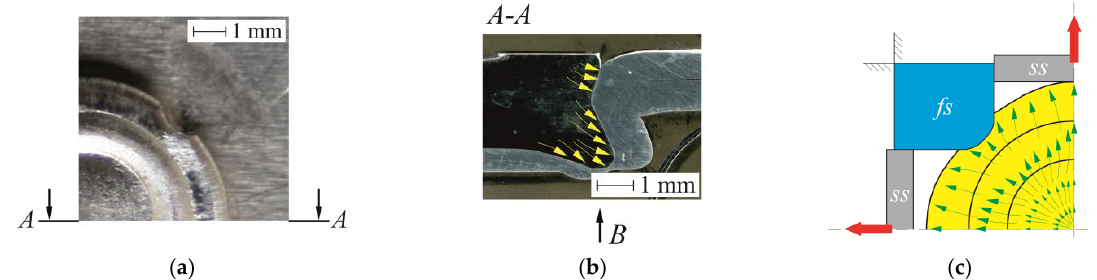
Figure 12. The characteristic of CR joints: ( a ) fragments of the embossment (from die side), ( b ) material flow directions of the rivet material in cross-section view, ( c ) material flow directions in relation to the fixed and movable segments of the die.